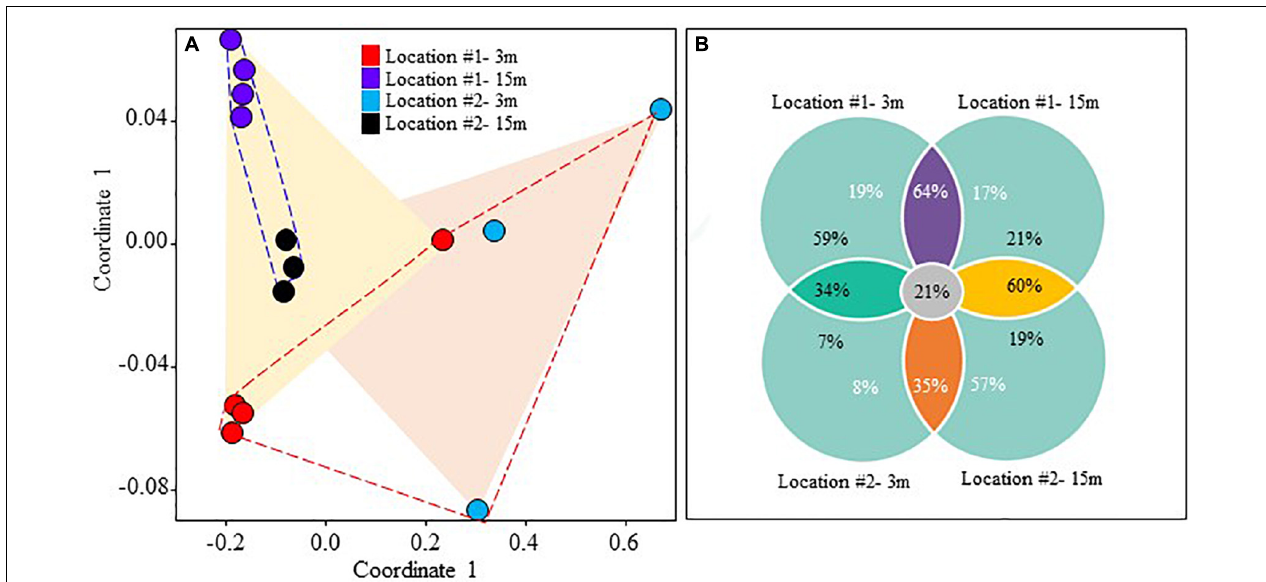
FIGURE 9 | (A) Non-metric multidimensional scaling (NMDS) ordination plot of fouling bacterial communities based on location and depth, (B) percentage of shared OTUs between different locations and